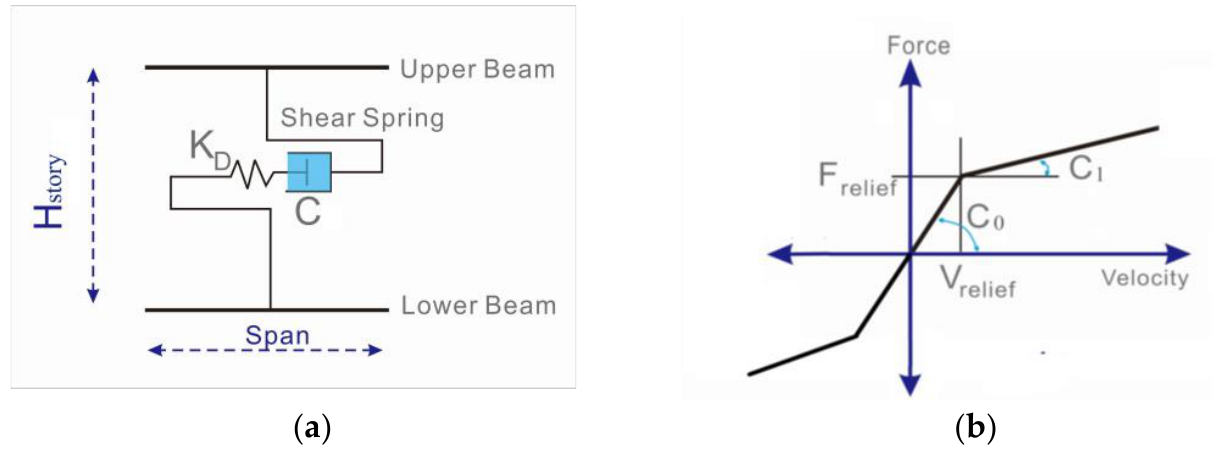
Figure 3. Bi-linear type oil damper: ( a ) element model, ( b ) force – velocity relationship of oil damper. Table 4. Technical parameters of hysteresis and oil dampers.